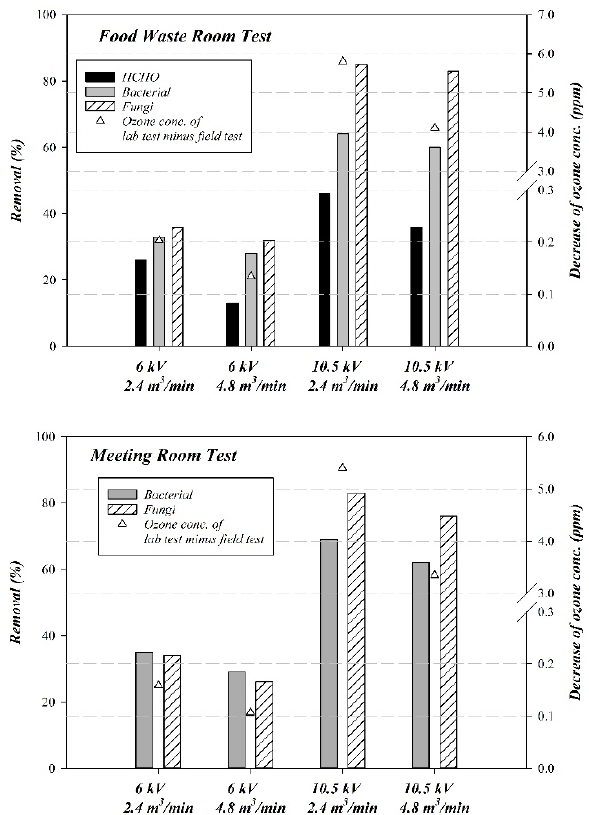
Figure 8. Comparing ozone concentration and air pollutant removal efficiency.